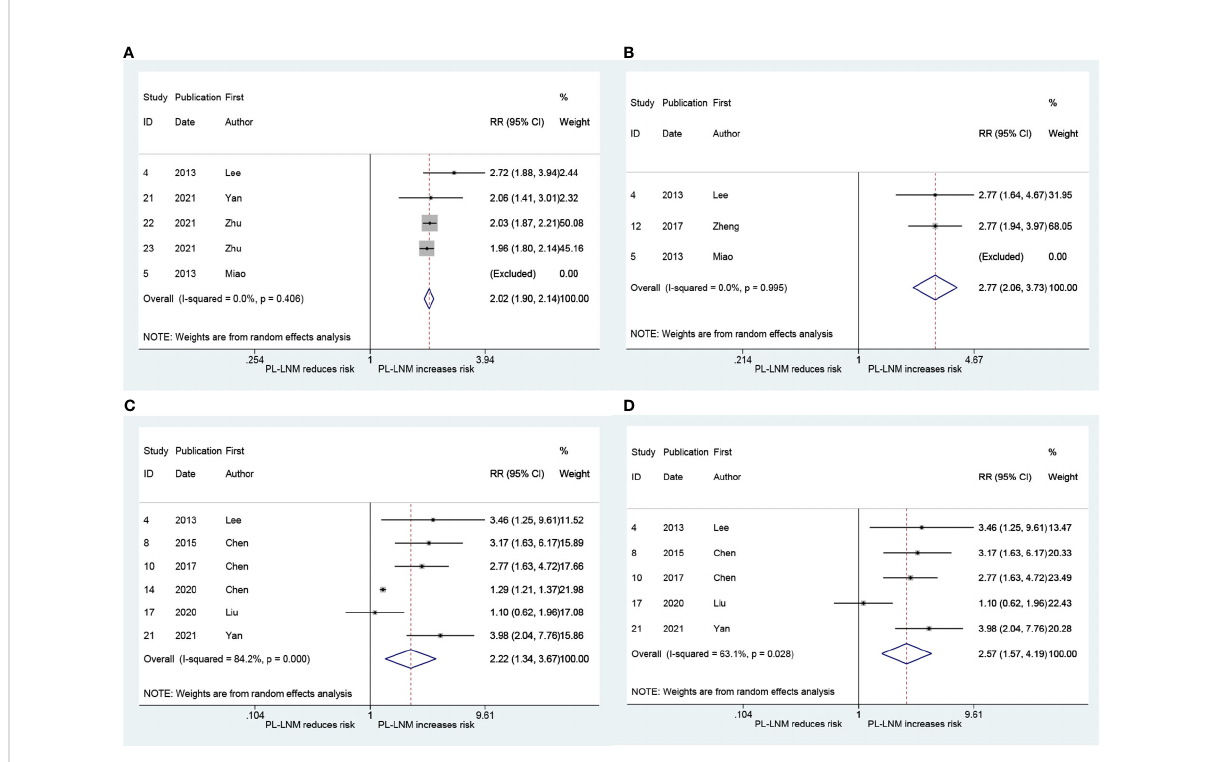
FIGURE 4 The relative risk for other groups ’ lymph node metastasis in patients with prelaryngeal lymph node metastasis (PL-LNM). (A) Ipsilateral paratracheal and/or pretracheal lymph node metastasis. (B) Pretracheal lymph node metastasis. (C) Contralateral paratracheal lymph node metastasis. (D) Contralateral paratracheal lymph node metastasis in the subgroup of patients without lateral lymph node